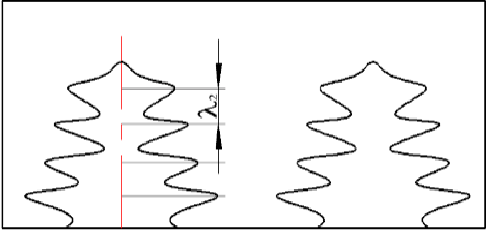
Figure 6. The measurement process of the secondary dendrite arm spacing using the linear intercept method.